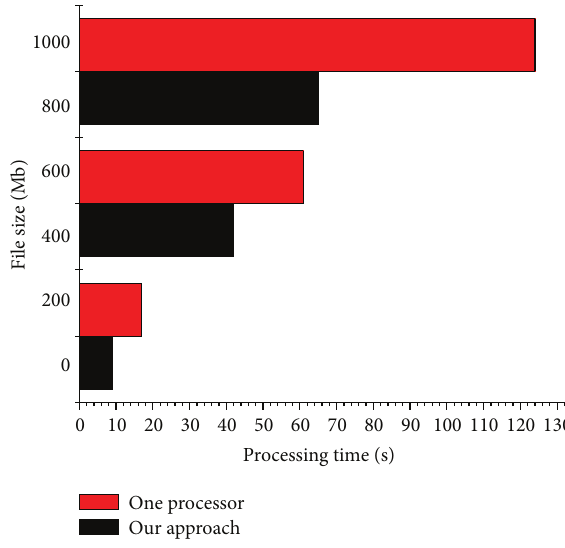
Figure 5: Objective value comparison with user mobility.